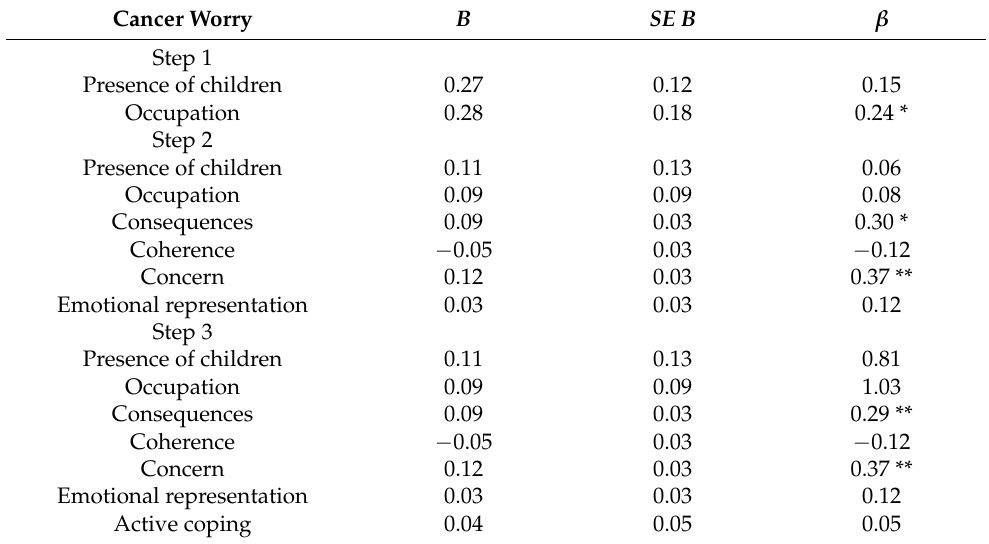
Table 5. Multiple stepwise regression analysis (method enter, using three steps), prediction of cancer worry and depressive symptoms by demographic variables, the illness representation dimensions and coping